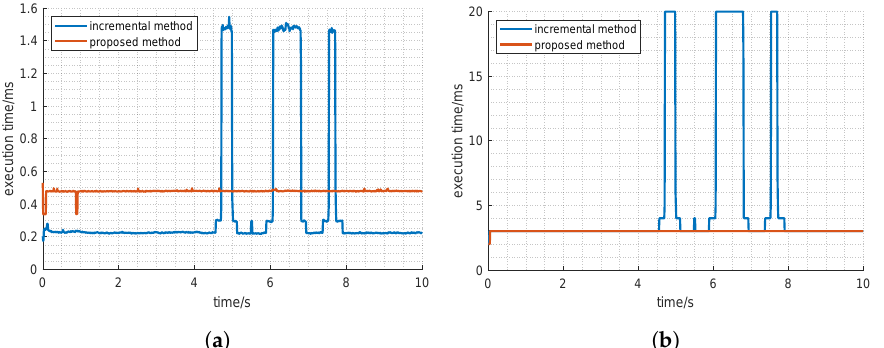
Figure 9. Comparison of iteration count and execution time with the incremental method; ( a ) execution time; ( b ) iteration count. Table 4. Statistics of forward kinematics of two